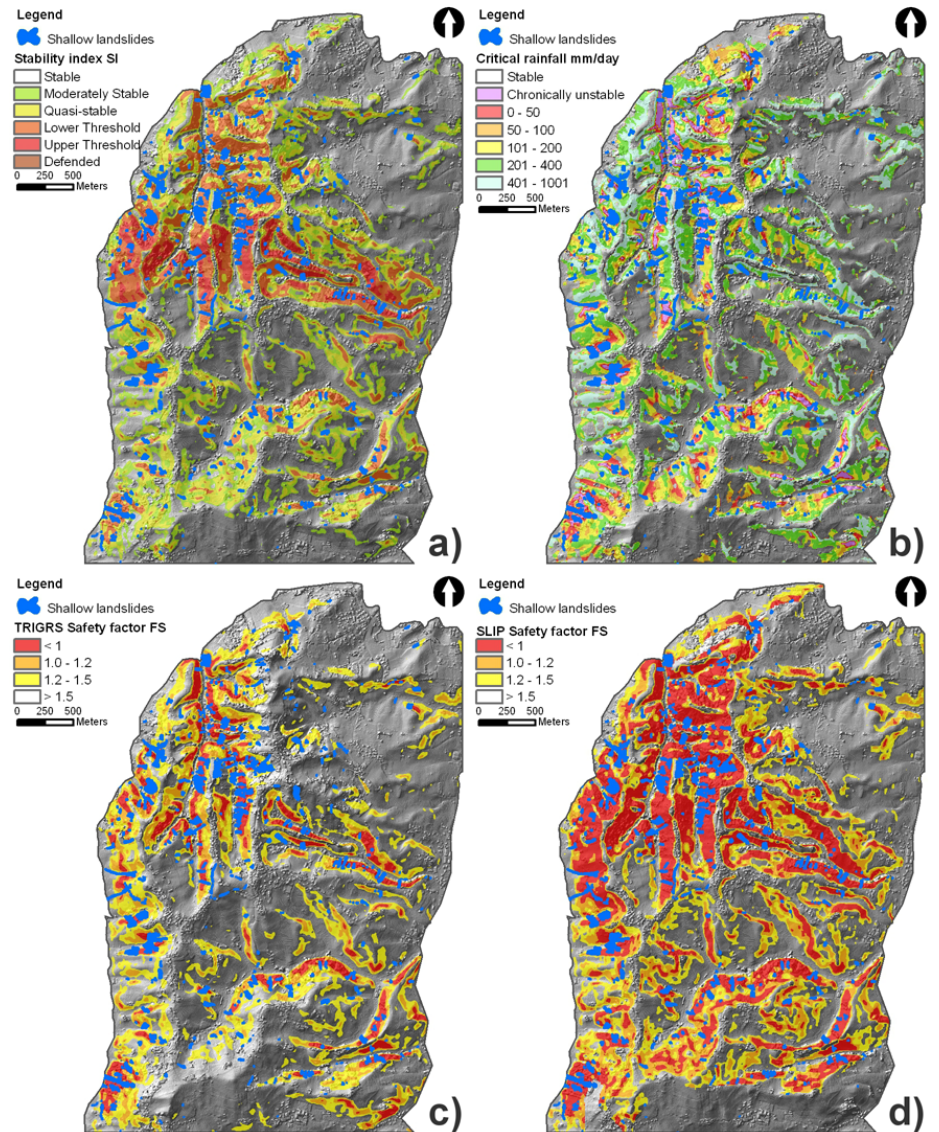
Fig. 6. Landslide susceptibility map of area 1: (a) Stability index map obtained by SINMAP; (b) Critical intensity of rainfall (mmday − 1 ) computed by SHALSTAB; (c) Safety factor map obtained using TRIGRS; and (d) Safety factor map obtained using